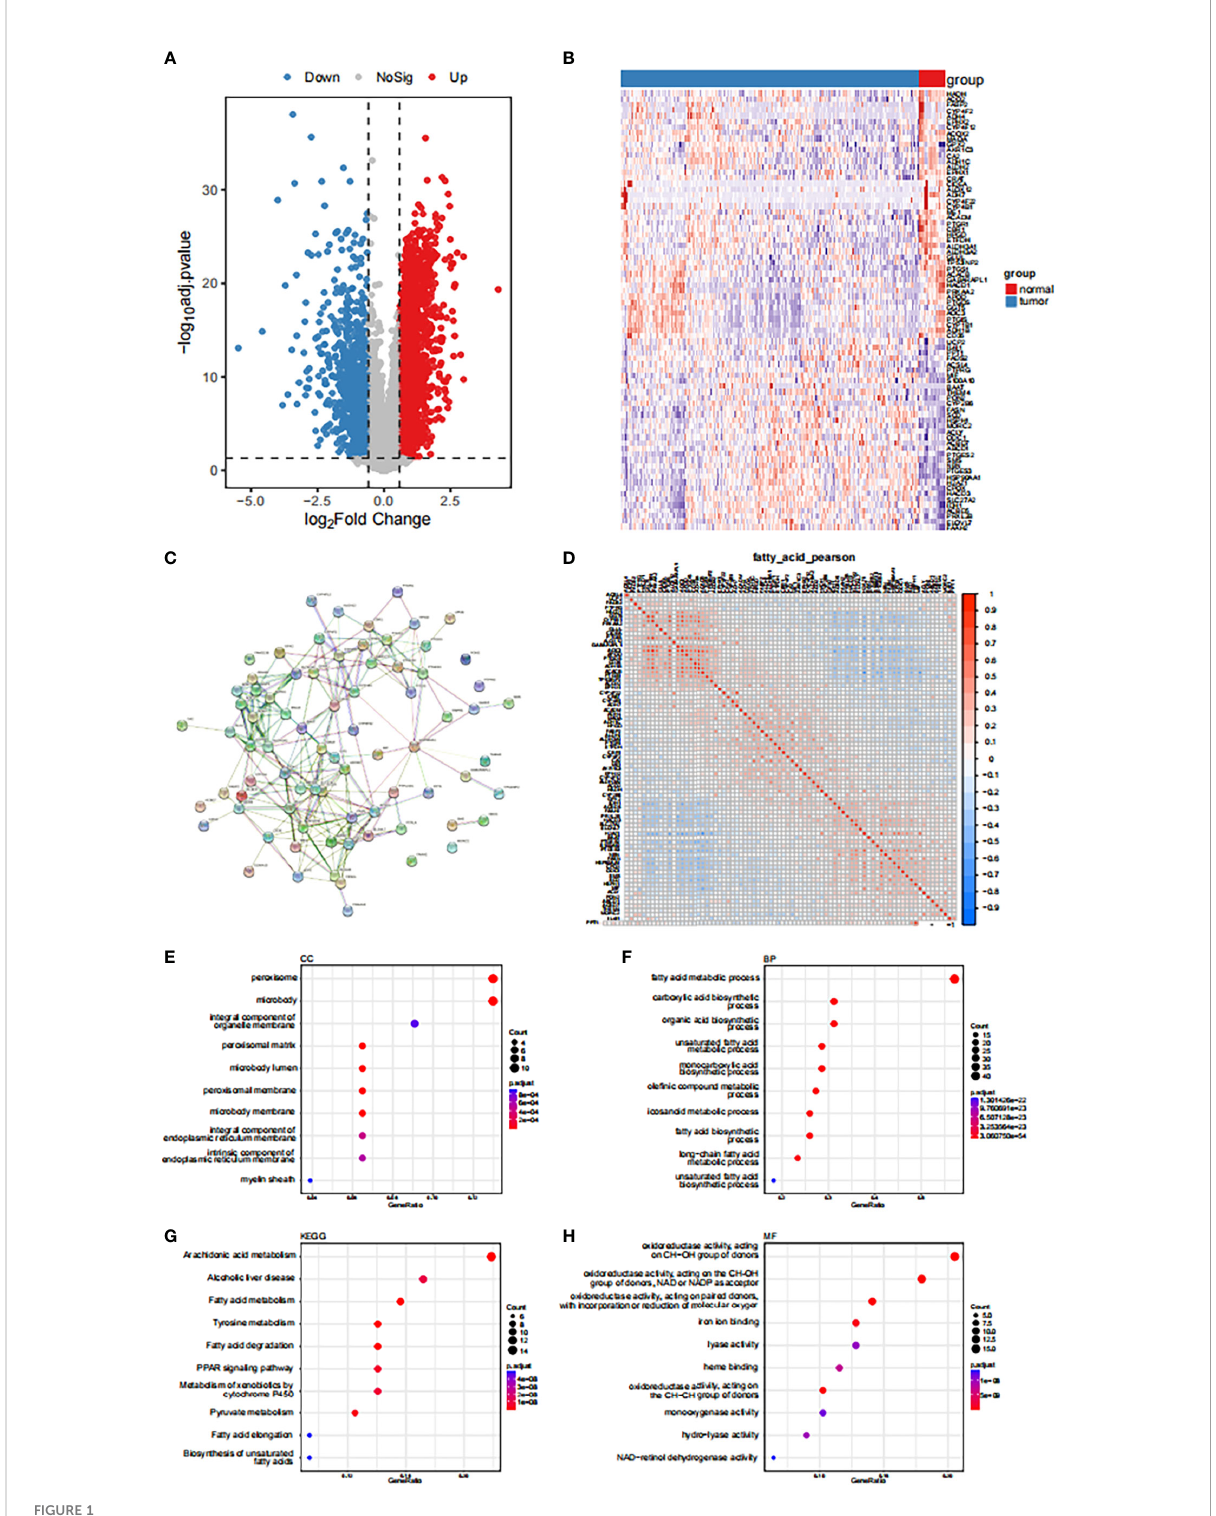
FIGURE 1 Expression disturbance of fatty acid-related genes in tumors (A) Volcanogram of fatty acid related genes differentially expressed in gastric cancer and paracancerous tissues. (B) Heat map of differentially expressed fatty acid-related genes. (C) Based on the differentially expressed fatty acid related genes, the PPI network was constructed by using STRING database. (D) Expression correlation analysis of genes related to differential fatty acids. (E-H) GO functional enrichment analysis of genes related to differential fatty